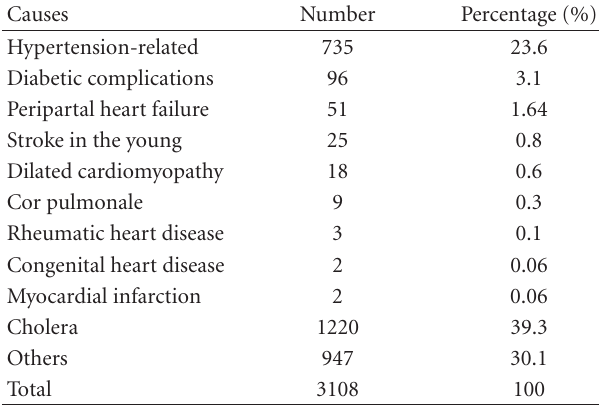
Table 1: Shows spectrum of cardiovascular admissions in the medical wards of